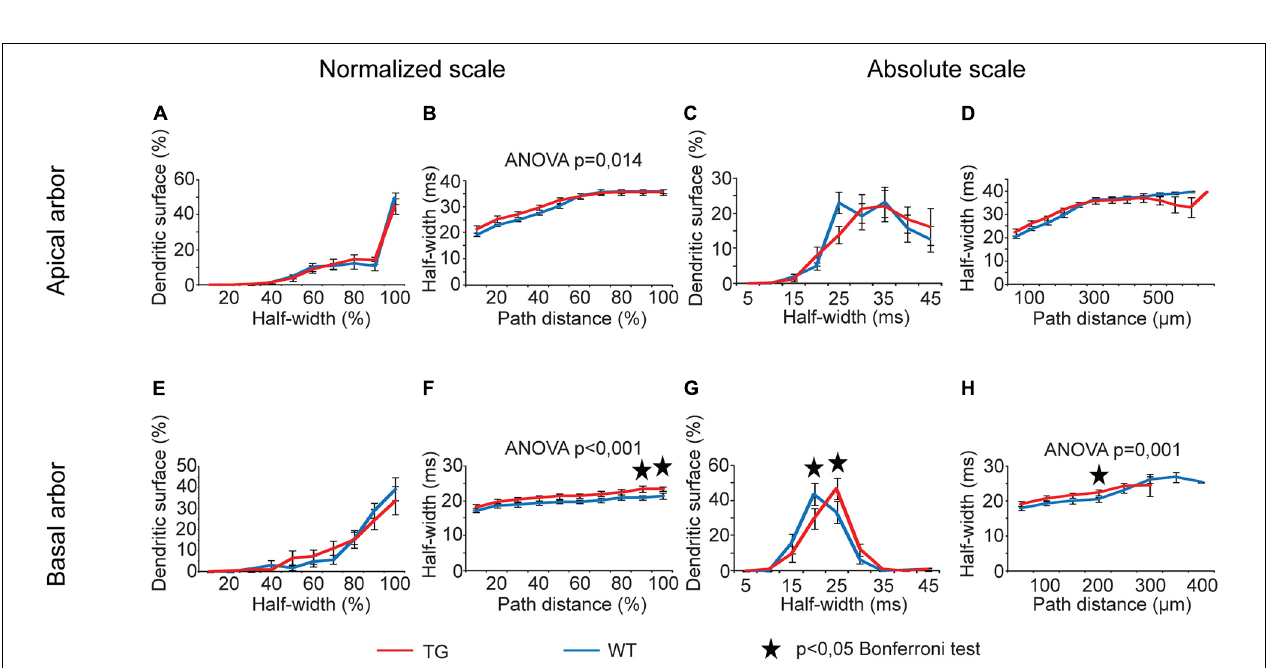
FIGURE 10 | Alterations in half-widths of somatic EPSPs in advanced tauopathy. Half-widths of somatic EPSPs, in response to locally generated dendritic synaptic conductance changes at different distances from the soma, were compared in WT and TG neurons (blue and red lines, respectively). These conductance changes mimicked AMPAR-mediated single synaptic activities. Asterisks mark path distance and half-width intervals where simulated PSPs, after traveling to the soma, led to statistically significant half-widths of somatic EPSPs in WT and TG neurons (Bonferroni post hoc test, p < 0.05).